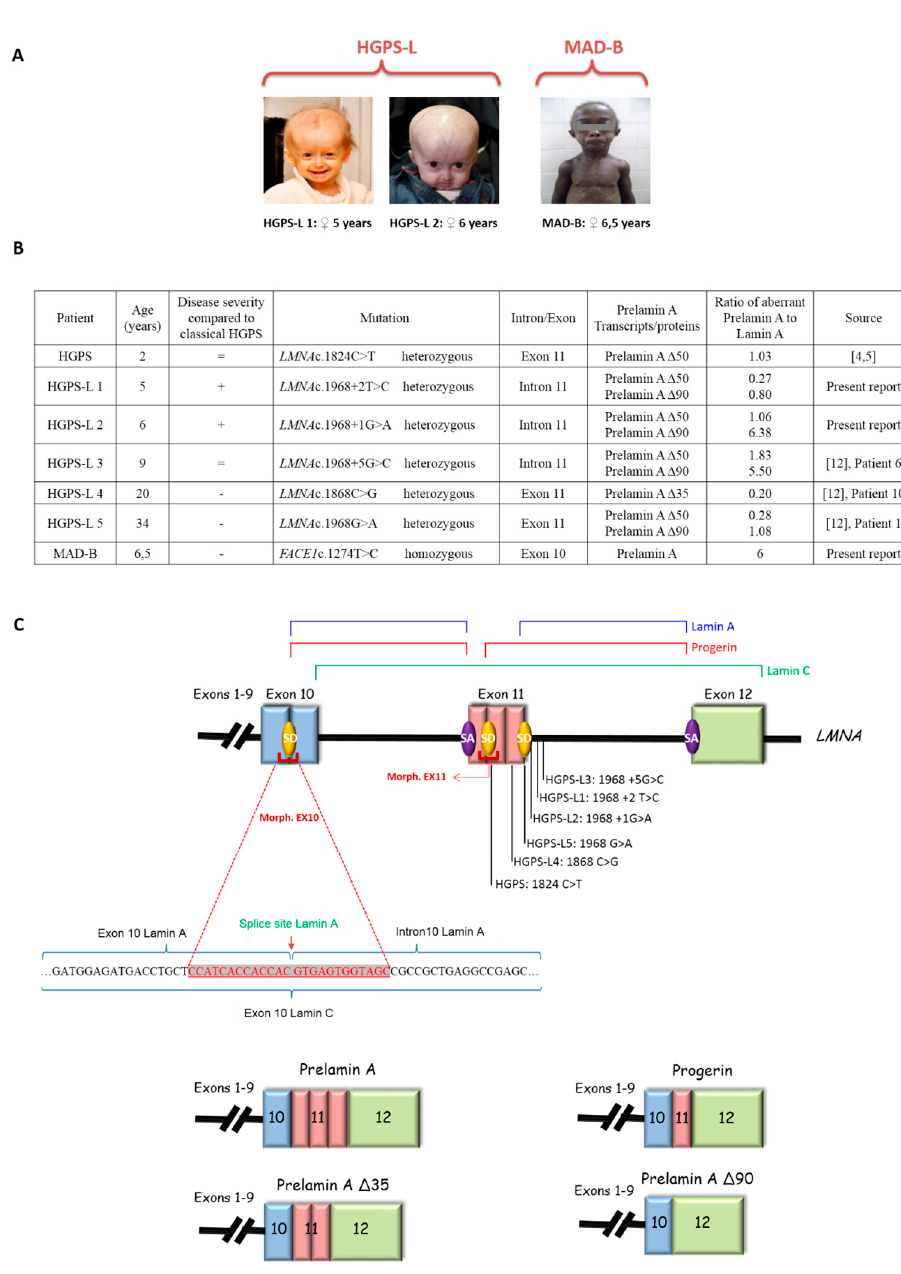
Figure 1. Clinical and molecular characterization of the patients. ( A ) Facial features of Hutchinson-Gilford Progeria Syndrome-like (HGPS-like) and Mandibuloacral Dysplasia type B (MAD-B) patients reveal a spectrum of progeroid clinical features including alopecia or sparse hair, thin and transparent skin with loss of subcutaneous fat and prominence of subcutaneous vessels, broad forehead with frontal bossing. ( B ) Molecular characterization of LMNA and FACE1(ZMPSTE24) gene mutations in HGPS-like and MAD-B patients eliciting aberrant Prelamin A splicing or wild type Prelamin A accumulation. Variable disease severities compared to classical HGPS are indicated with “+”: more, “ − “: less, or “=”: equal severity. The ratios of aberrant Prelamin A to Lamin A isoforms are shown, issued from Western Blot data, except for Prelamin A against which no antibodies are available and so were determined based on the transcript levels. ( C ) Schematic representation of the aberrant Prelamin A isoforms and the morpholino-based strategy for LMNA splicing modulation. SD: Splice Donor site, SA: Splice Acceptor site.